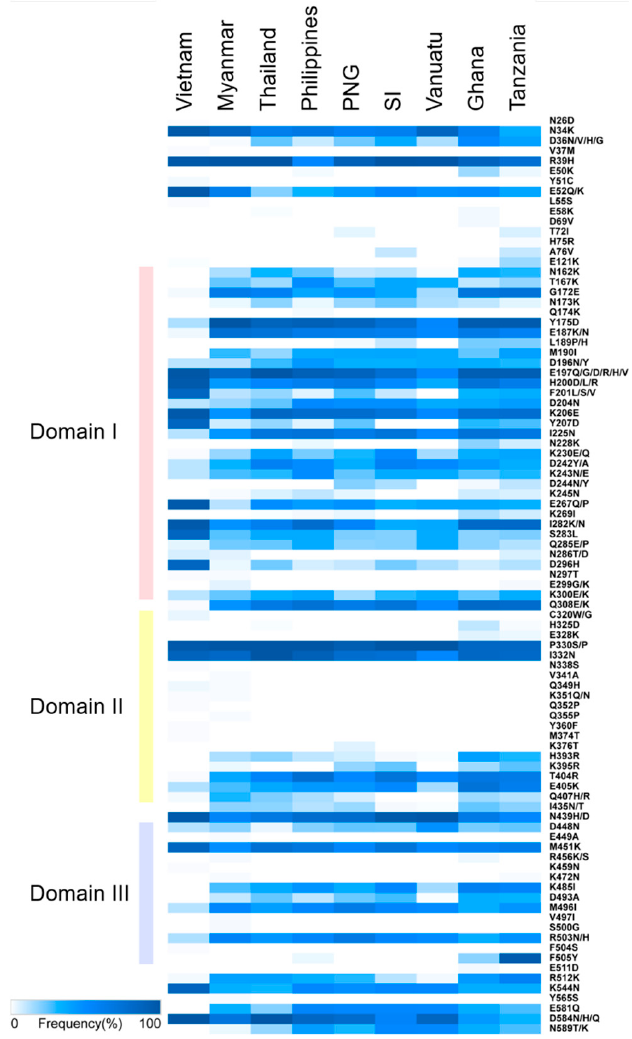
Figure 3. Summary of amino acid polymorphisms of pfama-1 observed in global P. falciparum isolates. Positions and frequencies of amino acid changes detected in global pfama-1 were compared. Each domain is highligthed by distinct colors: domain I (red); domain II (yellow); and domain III (blue). Overall patterns of amino acid changes detected in global pfama-1 were similar, but frequencies of each amino acid change differed by country. Some amino acid changes were characterized by country or continent. PNG, Papua New Guinea; SI, Solomon Islands. Heatmap was generated using Morpheus (https://software.broadinstitute.org/morpheus/; accessed on 16 November 2021). The global patterns except Vietnamese pfama-1 have been analyzed previously [25], and the previous data were applied to analyze overall patterns.